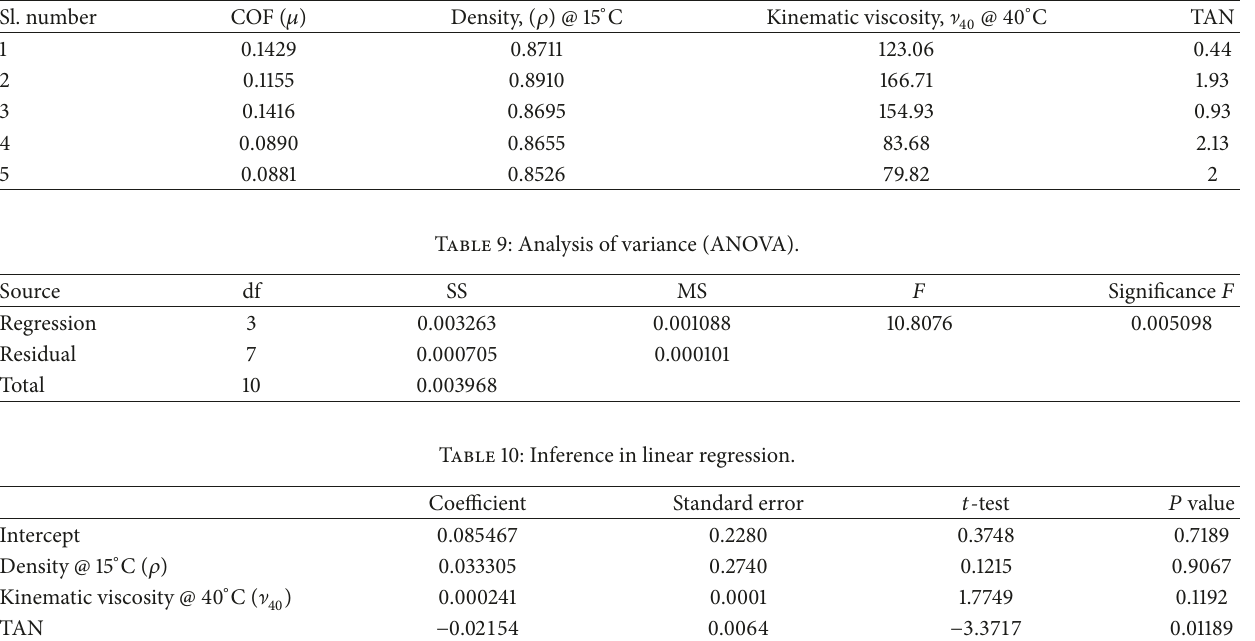
Table 8: Data for regression analysis.